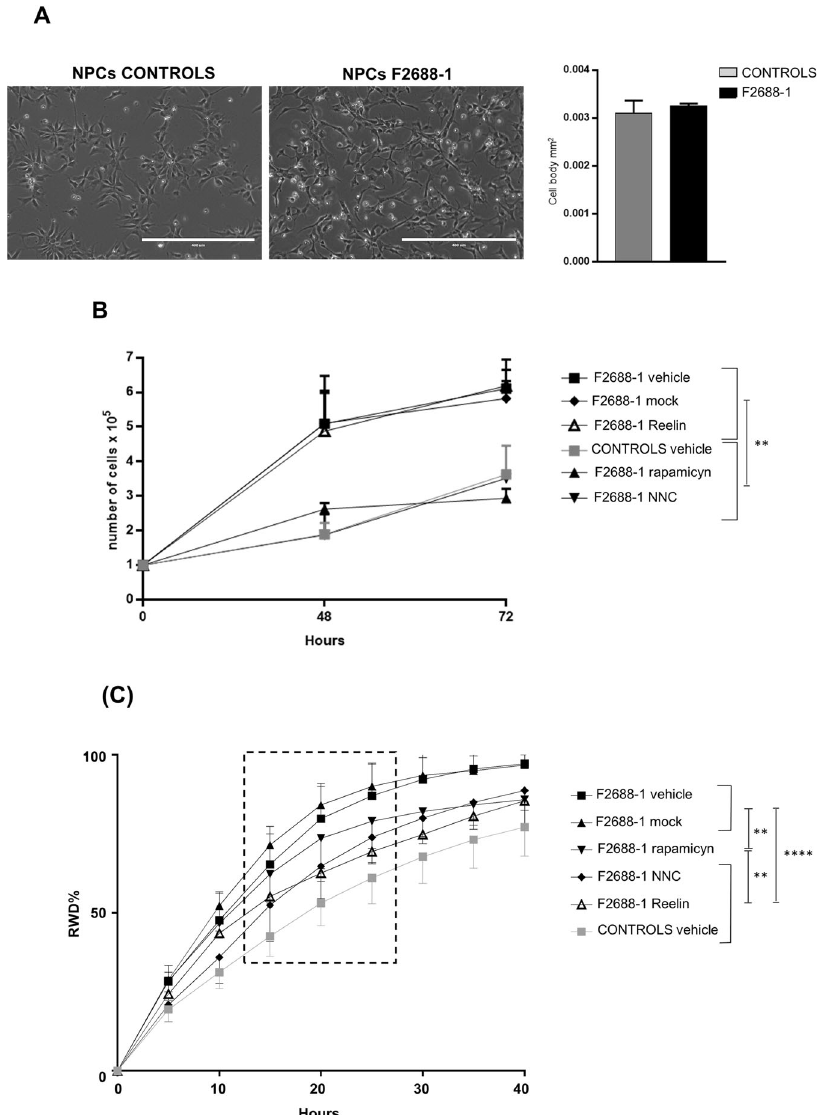
Fig. 4 Mutant Cav3.2-mediated hyperfunction of mTORC1 signaling acts alone to cause enhanced proliferation of F2688-1-derived NPCs and together with impaired Reelin signaling in the abnormal migration of these cells. A Representative phase-contrast microscopy photographs of control- and F2688-1-derived NPCs. The bar graph shows the median cell body size (including soma size and all cell surface projections) of control-derived NPCs ( n = 4) and F2688-1-derived NPCs (NPCs derived from 2 iPSC clones). There were no signi fi cant differences in median body size between the groups. B Line graph showing cell proliferation curves (live cell numbers at Day 0, 48 h, 72 h) of control-derived NPCs ( n = 4) and F2688-1-derived (NPCs derived from 2 iPSC clones) cultured in the presence of either vehicle, 1 μ M of NNC 55-0396 (NNC), or 100 nM of rapamycin; and in the presence of either mock-conditioned medium (mock) or Reelin-conditioned medium (Reelin). The graph shows the median value and interquartile range for each group. F2688-1 NPCs show signi fi cantly higher proliferation rates compared with control NPCs, which were completely rescued by treatment with either rapamycin or NNC. On the other hand, treatment with Reelin had no effect on the proliferation of F2688-1 NPCs. C Line graph showing the percentage relative wound density (RWD) over time in control-derived NPCs ( n = 4) and in F2688-1-derived NPCs (NPCs derived from 2 iPSC clones) cultured in the presence of either vehicle, 1 μ M of NNC, or 100 nM of rapamycin; and in the presence of either mock or Reelin. The graph shows the median value and interquartile range for each group. F2688-1 NPCs exhibit signi fi cantly higher migration rates compared with control NPCs, which was signi fi cantly attenuated by treatment with rapamycin, and completely rescued to levels equal to those of the untreated control NPCs in the exponential phase of the healing curve by treatment with either NNC or Reelin (analyzed time interval: 15 h – 25 h). ** p ≤ 0.01, **** p ≤